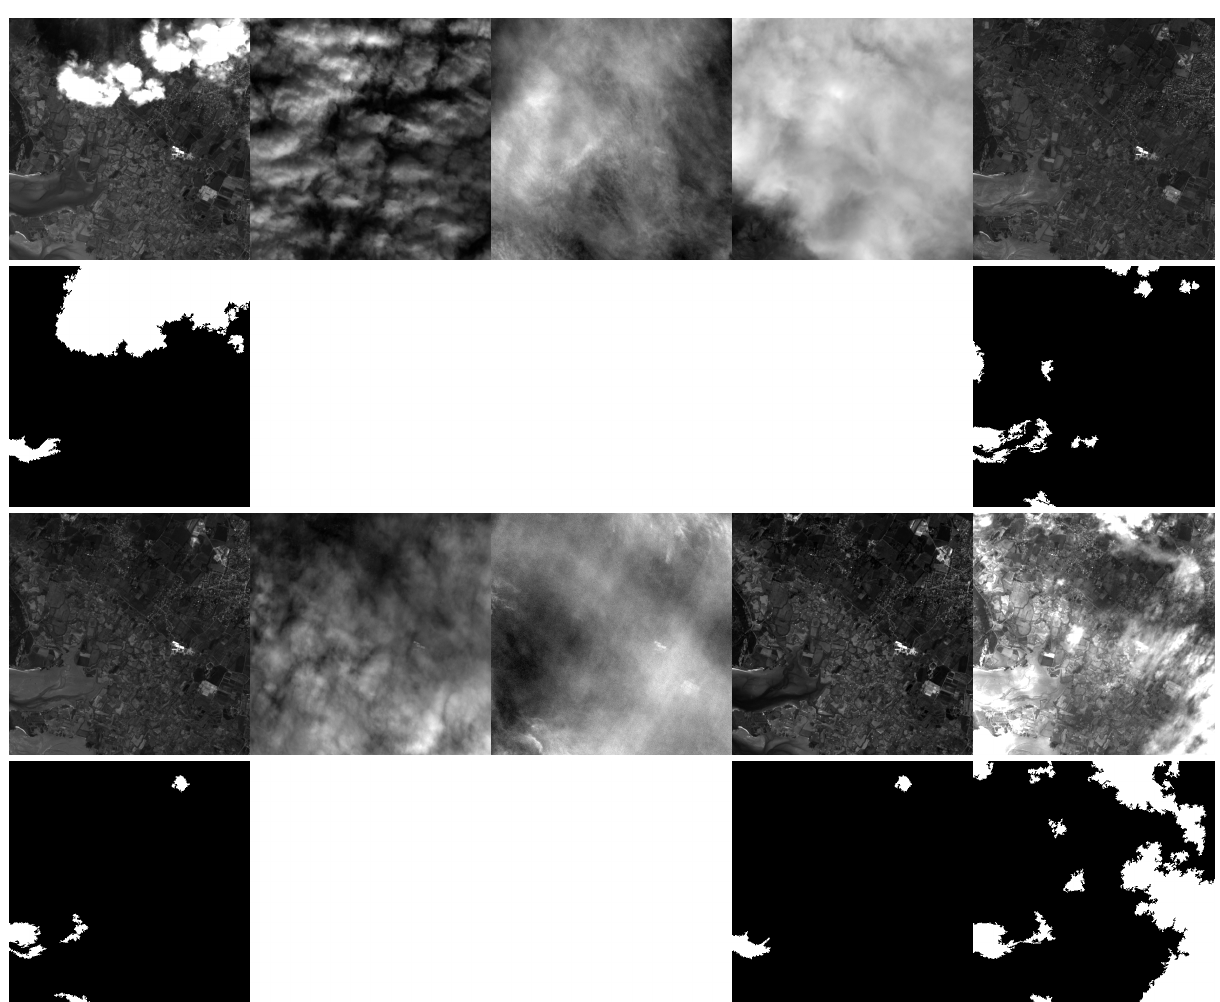
Figure 3. Ground visibility computed with the proposed algorithm in a time series of ten images from the Sentinel-2 constellation. First and third rows: input images. Second and fourth rows: resulting ground visibility maps, where black pixels correspond to visible while white corresponds to not visible . The images are 496 × 496 and the ten ground visibility masks were jointly computed in about one second on an 1.2 GHz Intel Core M